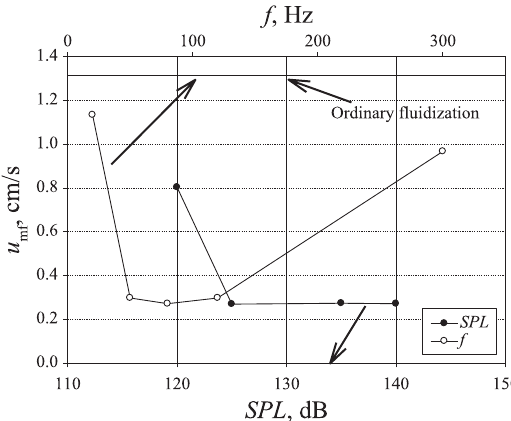
Fig. 14 Effect of SPL (at fixed f = 80 Hz) and frequency (at fixed SPL = 140 dB) on u mf . Reprinted with permis- sion from Ref. [Raganati et al., 2014b]. Copyright: (2014) Elsevier